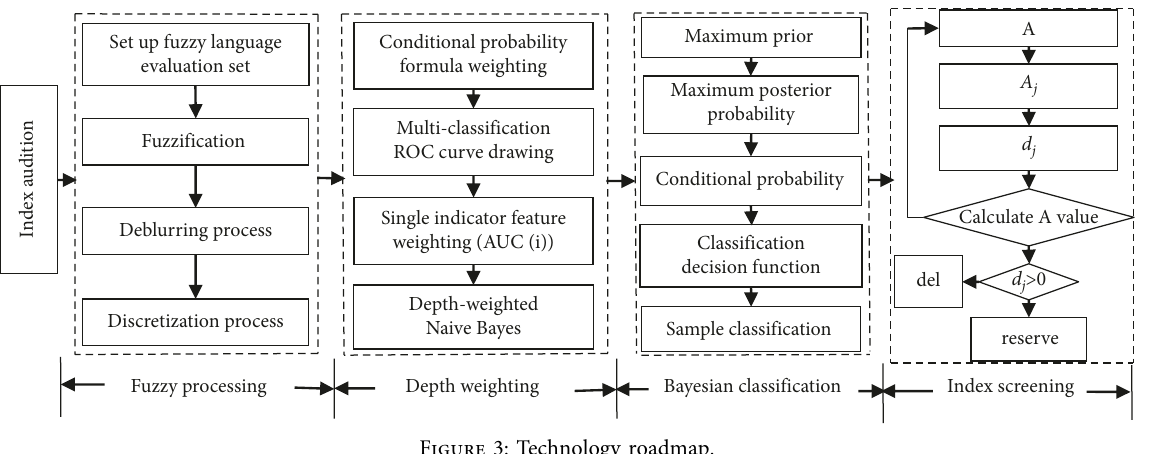
Figure 3: Technology